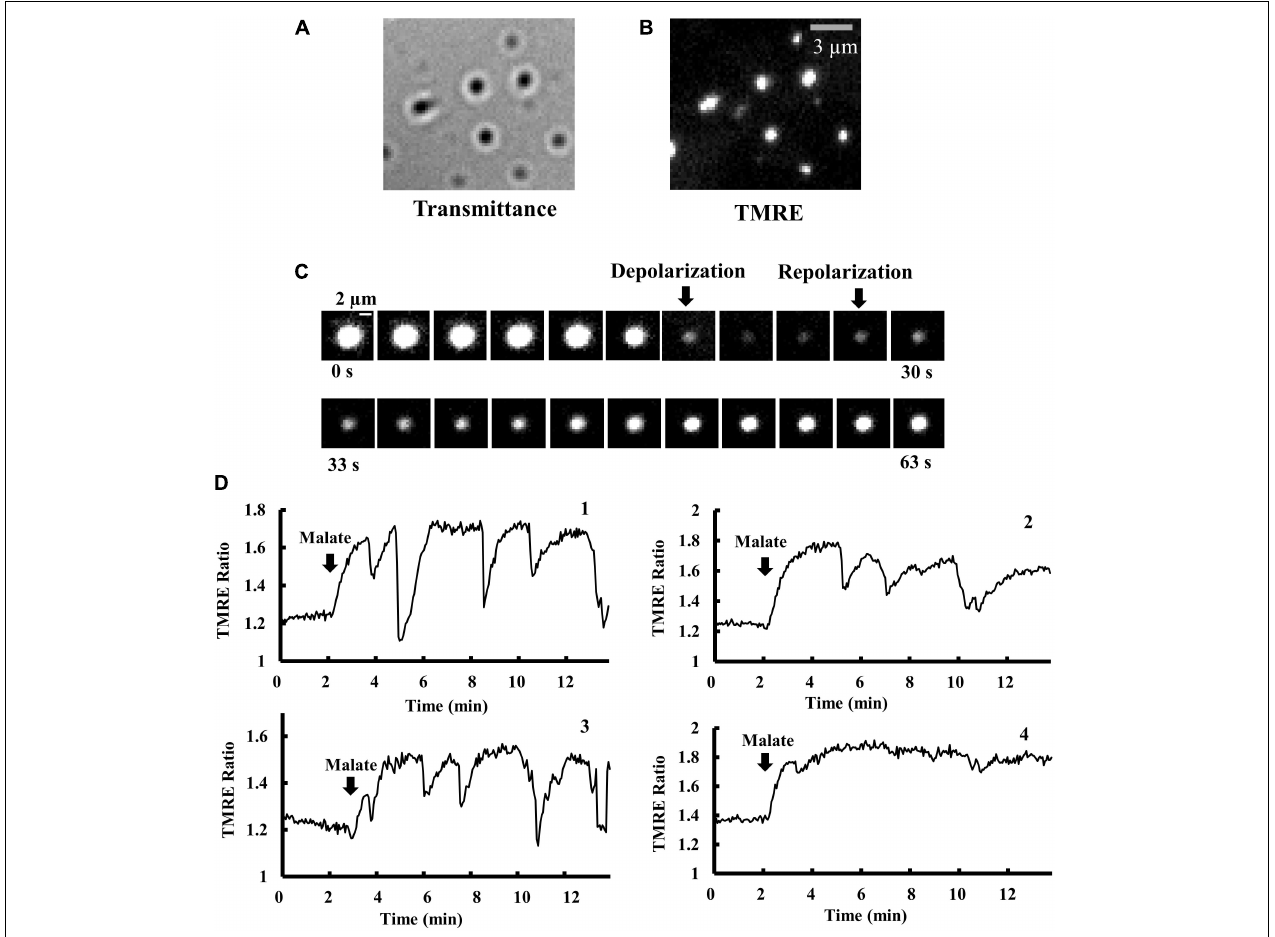
FIGURE 1 | Time course of changes in (cid:49) ψ m in isolated mitochondria. (A,B) Optical images of isolated mitochondria adsorbed on a cover slip. (A) Brightfield and (B) fluorescence images of the same microscopic field as (A) . Bar, 3 µ m. (C) Time-resolved fluorescence images of TMRE in a single mitochondrion. TMRE fluorescence was monitored in the presence of malate (5 mM). The arrows show the onset of depolarization and polarization. The time interval between images is 3 s. Bar, 2 µ m. (D) Membrane potential ( (cid:49) ψ m ) in a single mitochondrion in response to malate addition. The vertical axis represents the fluorescence intensity of TMRE in a single mitochondrion, normalized by TMRE fluorescence in the buffer (TMRE Ratio). At t = 2 min, 5 mM malate was added. The fluctuations of (cid:49) ψ m significantly depend on individual mitochondria. (cid:49) ψ m in mitochondria 1–3 is fluctuating, but not in mitochondrion